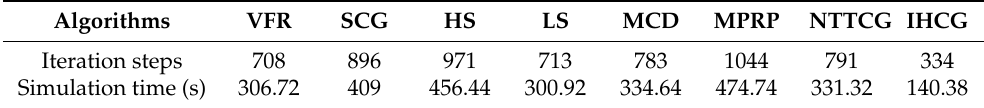
Table 2. Comparison of simulation performance by different CG algorithms.